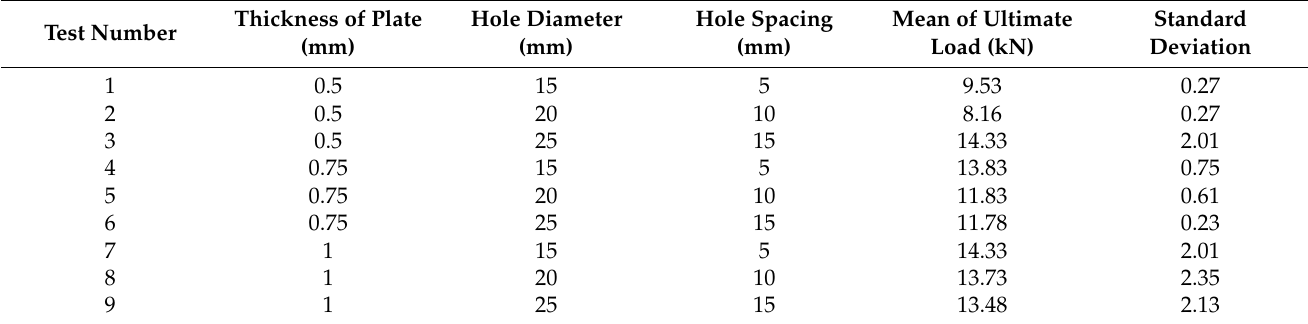
Table 5. Summary of ultimate pull-out bearing capacity of